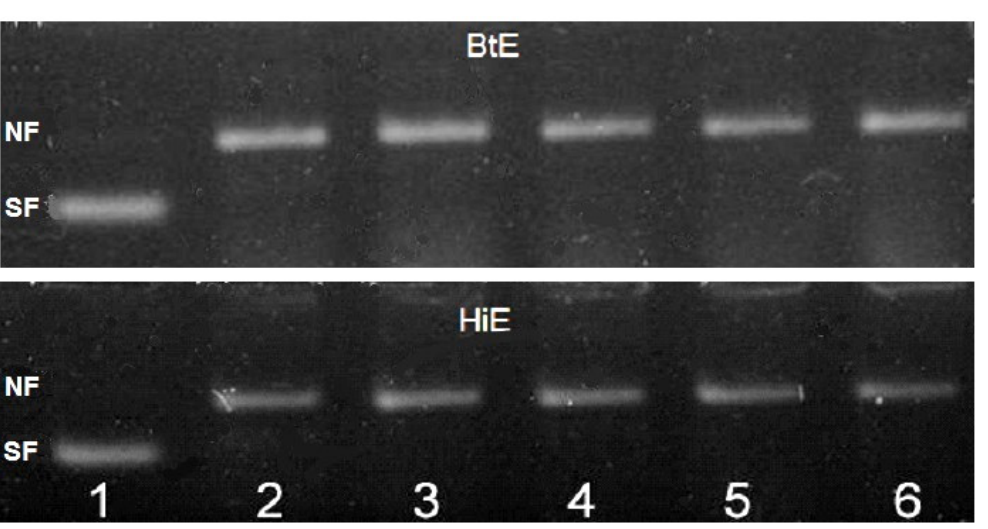
Figure 4. Inhibition of T4-endo V activity by B. triquetrum and H. incrassata extracts. (1) Negative control; (2) Positive control; (3–6) T4-endo V exposed to extract (1.0 mg/mL) during 0, 10, 30 and 50 min. SF: supercoiled form. NF: open nicked form.